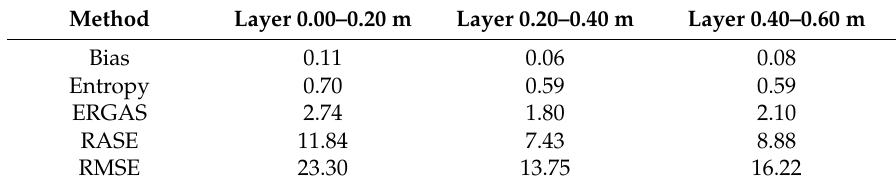
Table 3. Quantitative Analysis of original GPR results with the fused image results through BNN application in different